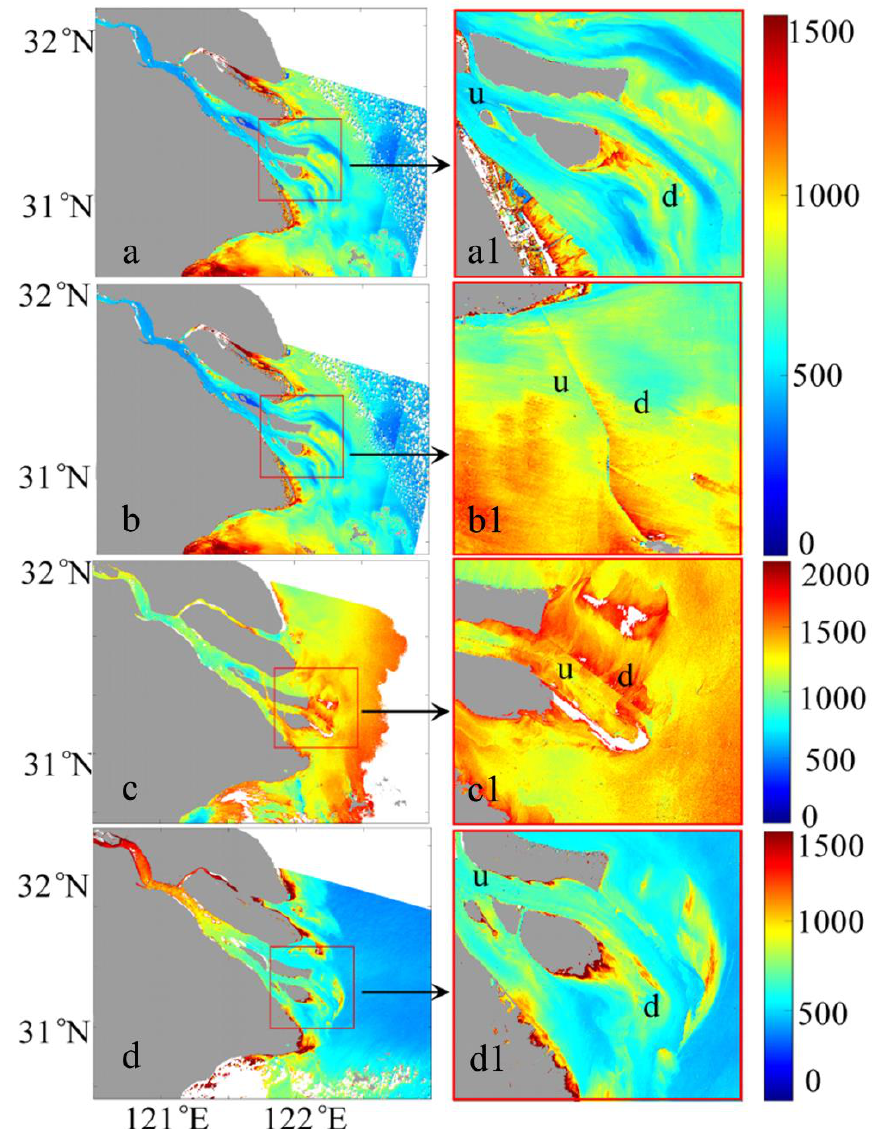
Figure 9. SSC distribution obtained from CZI image. ( a – d ): satellite images of different date. ( a1 – d1 ): Chl-a change upstream and downstream of island and project; u: upstream; d: downstream.